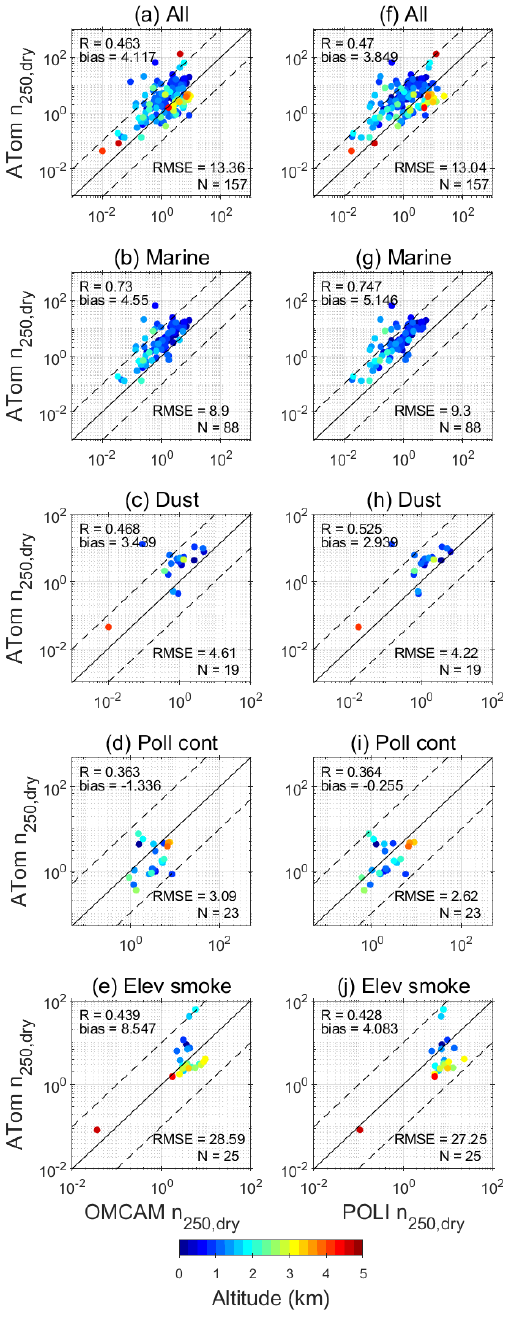
Figure 7. Same as Fig. 6 but for n 250 , dry .